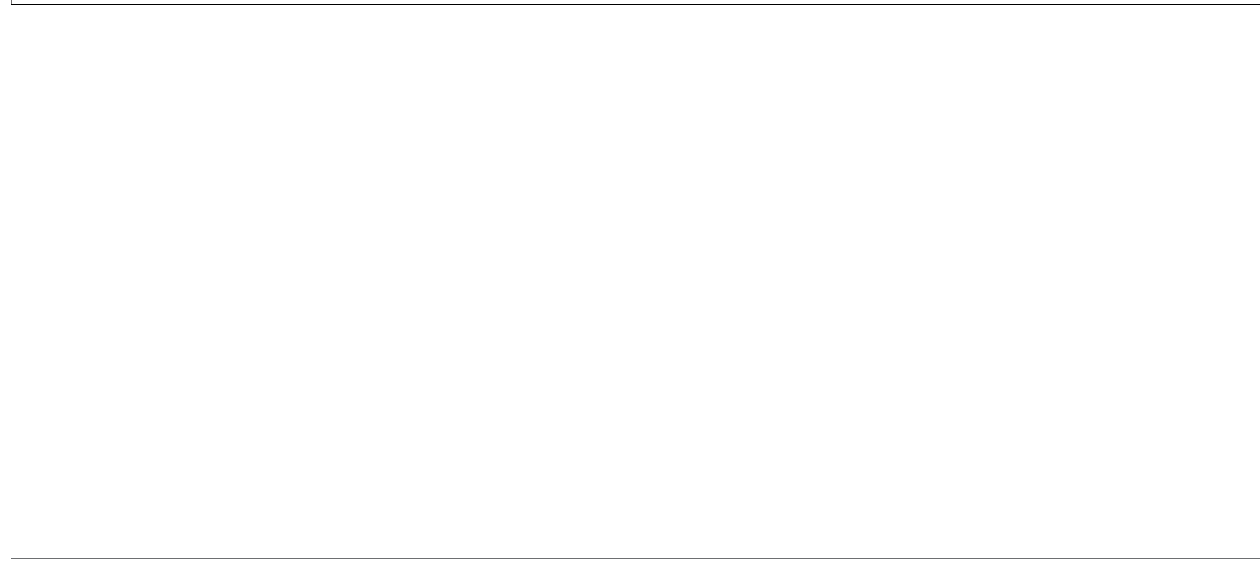
Frontiers in Pharmacology |